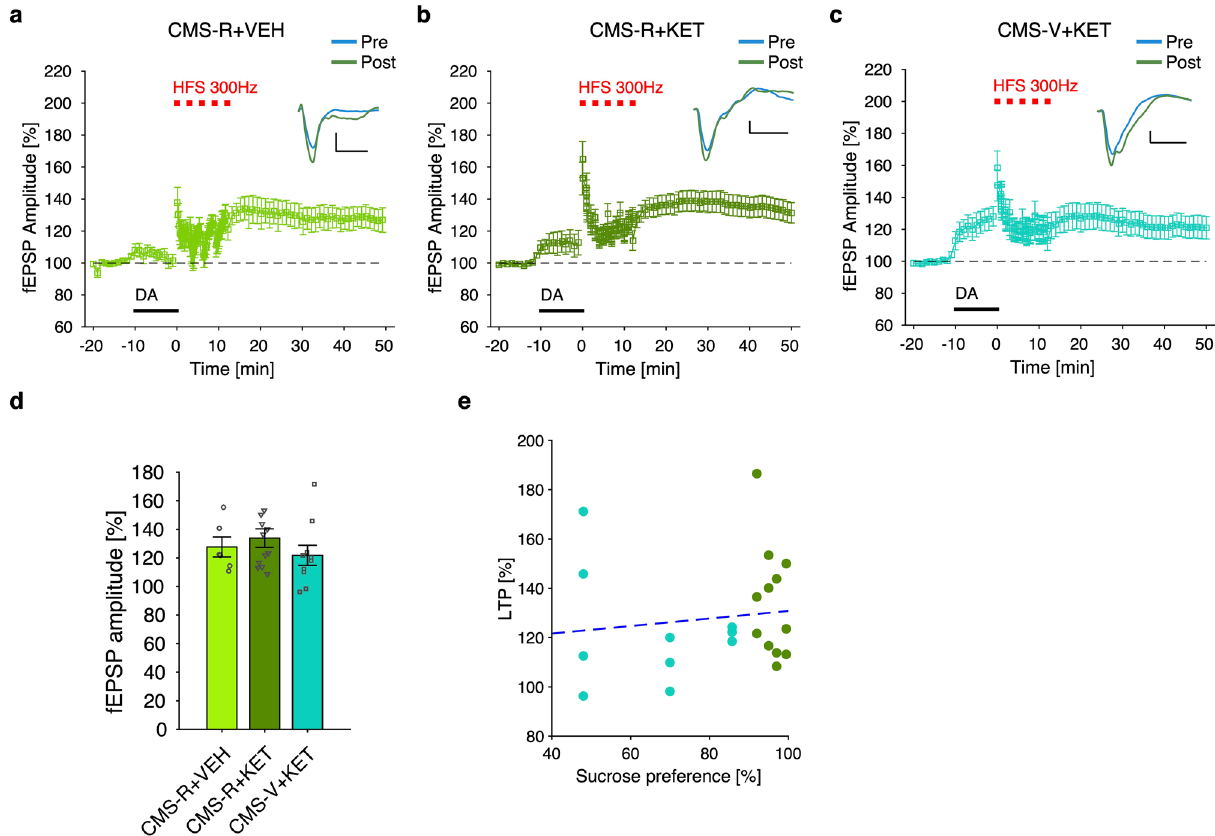
Figure 3. Acute sub-anesthetic ketamine treatment rescues differences in DA-LTP between resilient and vulnerable rats. ( a–c ) Time course of DA-LTP experiments in mPFC slices coming from CMS-R+VEH ( a ), CMS-R+KET ( b ) and CMS-V+KET ( c ) rats; ketamine (KET; 10 mg/kg) was administered 1.5 h before slices production; representative fEPSP responses before (blue) and after (green) DA-LTP are shown on top (scale bar: 20 ms × 0.2 mV). ( d ) Analysis of population data shows no significant difference among the three groups (n: CMS-R+VEH/CMS-R+KET/CMS-V+KET = 6/12/11 slices from 5/4/4 rats; permutation test, B–H correction: n.s.). ( e ) fEPSPs amplitude after DA-LTP was not correlated with sucrose preference in CMS-V+KET rats (Pearson’s correlation: r = 0.230; n.s.). DA dopamine, HFS high-frequency